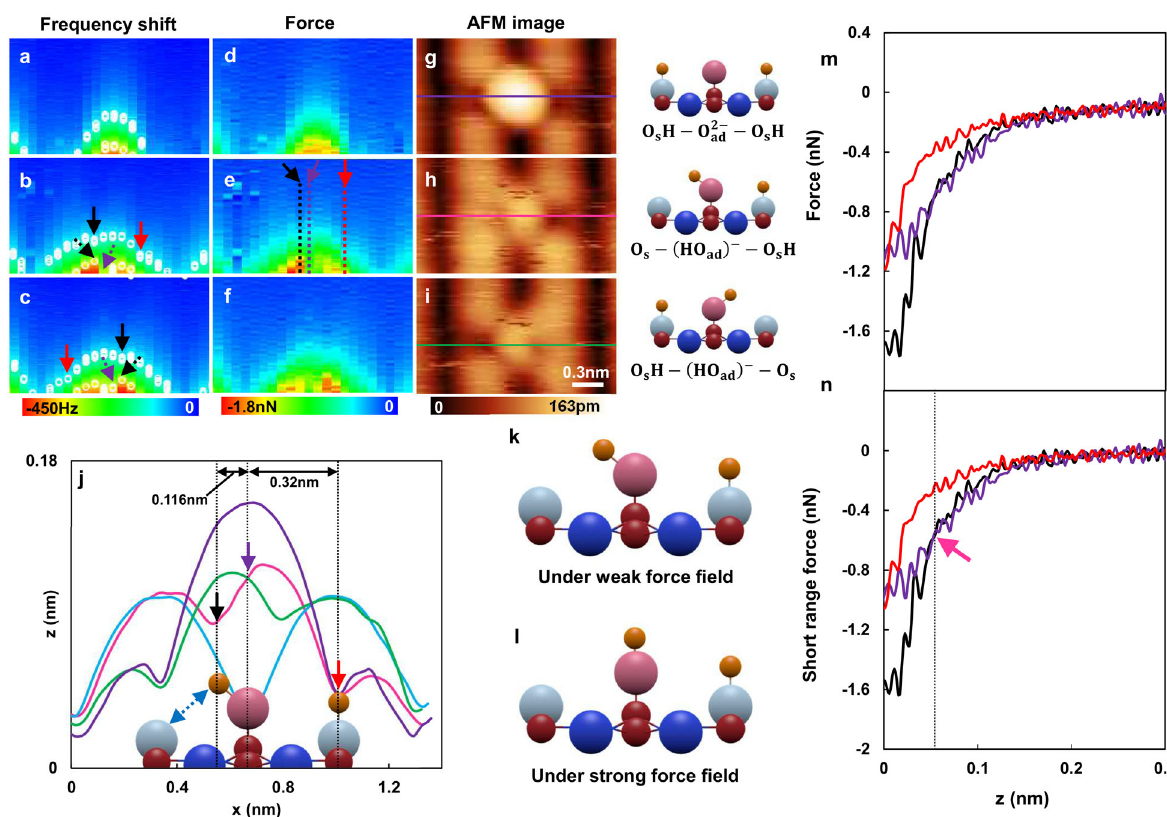
Fig. 5 Exploration of the atomic con fi guration of O s H − O ad 2 − − O s H, O s − (O ad H) − − O s H, O s H − (O ad H) − − O s . a – f Δ f (z) ( a – c ), and F ( z ) ( d – f ) maps for approach measured along the ½ 1 (cid:1) 10 (cid:2) direction. The white circle in a – c indicates the constant frequency of − 145 Hz and − 345 Hz. The black and red solid arrows in a – c indicate the slight dip positions in a constant frequency of − 145 Hz. The black and purple dotted arrow indicates the local maximum and minimum of − 345 Hz. Spectroscopy parameters for a – f : V bias = 0 V, 0.24 × 1.60 nm 2 . g – i AFM images of O s H − O ad 2 − − O s H, O s − (O ad H) − − O s H, and O s H − − O − − (O – i : 1.0 × 1.3 nm 2 . j Line pro fi les measured for the three species and substrate: O − O − (O 2 − − O ad H) s . Imaging parameters for g s H ad s H, O s ad H) − − O − − O − − O − O − (O − O − O − (O − (O − O 2 − − O 2 − − O s H, O s H ad H) s and O s ad s . Purple, O s H ad s H; pink, O s ad H) s H; green, O s H ad H) s ; light-blue, O s s . The schematic of the surface structure is superimposed in the graph. The blue dotted arrow indicates the interaction between the hydrogen atom and the oxygen row. The black and red solid arrows indicate the dip positions in the pink curve. The purple solid arrow indicate the middle of the structure. The black dotted lines are guides for the eyes. The positions of the line pro fi les in j are shown in different colors in g – i . k – l Schematic structure of O s − (O ad H) − − − O − O fi eld. m , n F ( z ) and F z ) curves obtained on top of the O − (O s H under weak and strong force SR ( s ad H) s H. The positions of the curves are indicated by the arrows, and the dotted lines inside j and e by different colors. The pink arrow in n indicates the cross point between black and purple (Fig. 4(a) → 4(c)). However, the suf fi cient tunneling current leads to the desorption of the hydrogen atom, not the lateral hopping of hydrogen atom on this surface as again shown in Fig. 3(a) – (d).